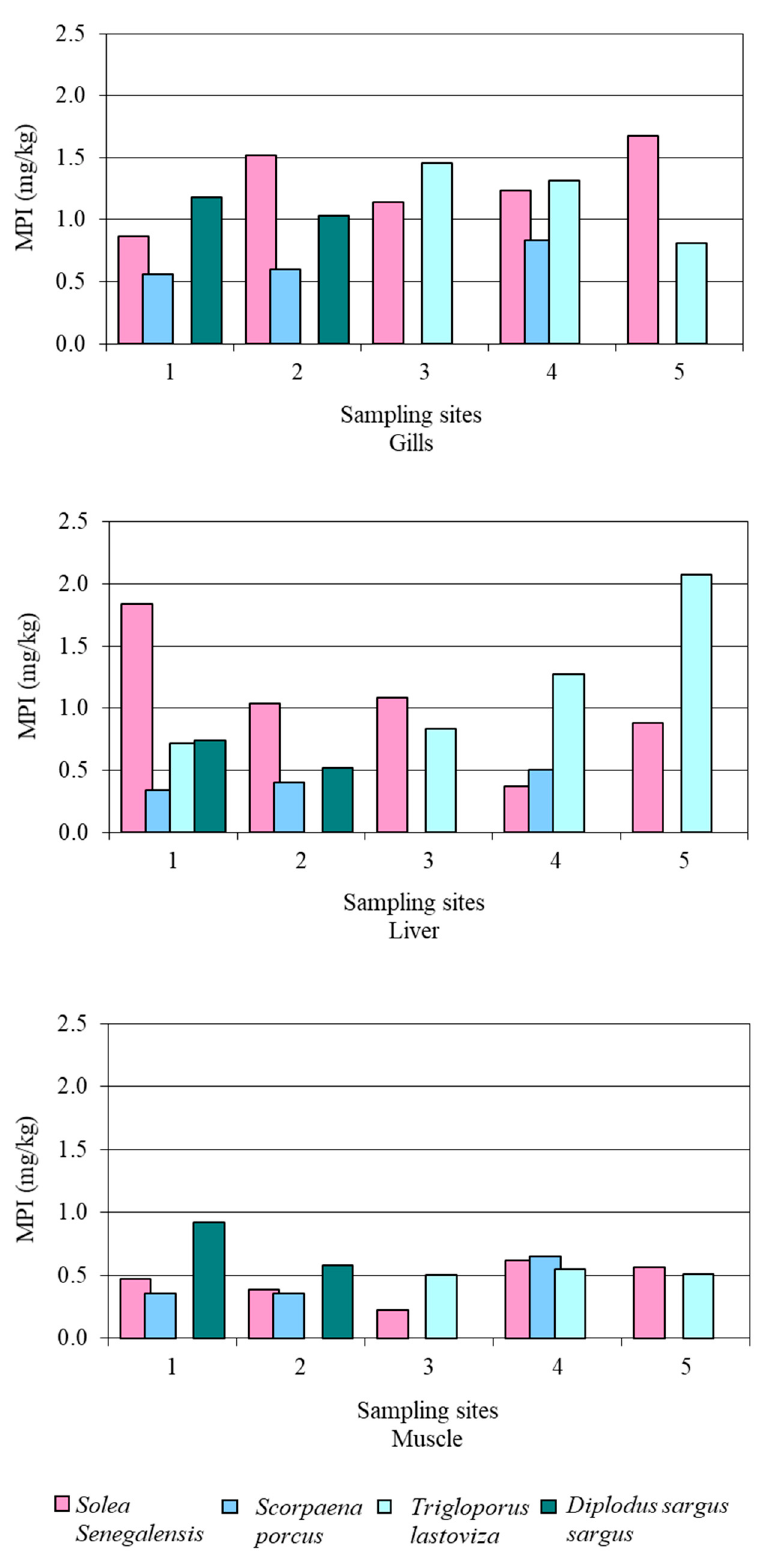
Figure 11. Metal pollution index for gills, liver and muscle of the four fish species collected at the five sampling sites.